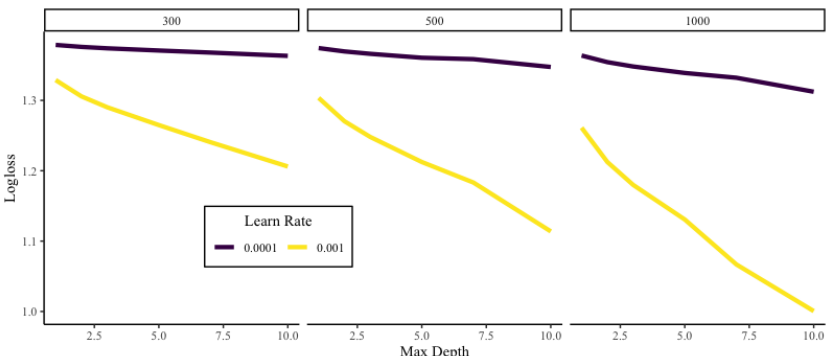
Figure 8. Visualization of the results from tuning random forests to predict claim frequency on the PD data. Here, we show the change in logloss across different values of max depth of each tree in the random forest. The left pane shows the results when mtry is 7, and the right pane shows the results when mtry is 20. Each pane contains two lines of different colors representing different minimum split improvements.